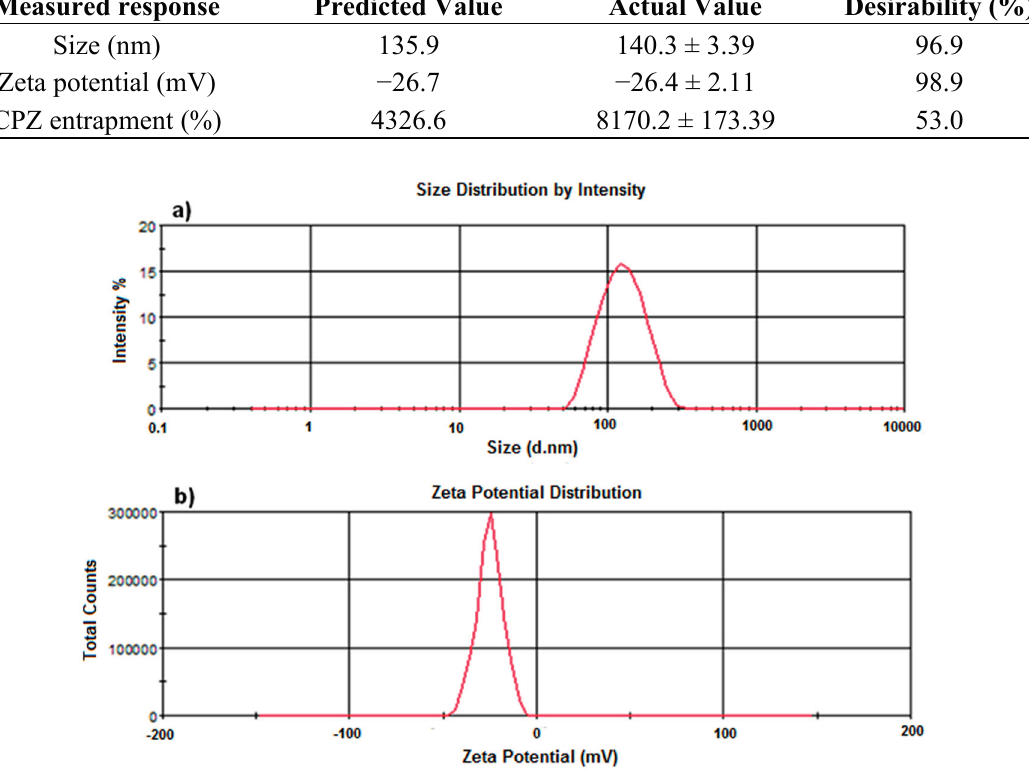
Figure 13. Distribution profiles of ( a ) size and ( b ) zeta potential of the optimized CPZ-loaded, PCL bases nanocapsule